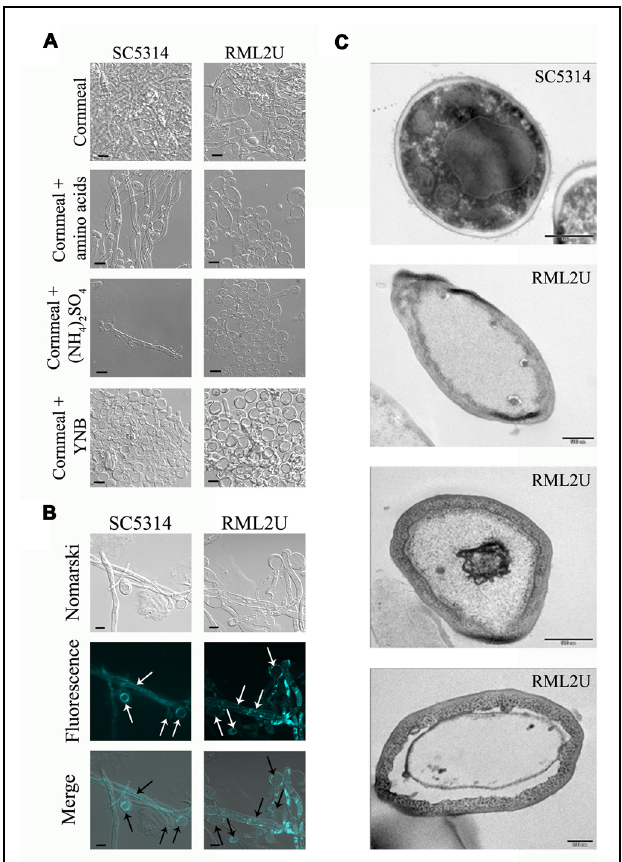
FIGURE 5 | Cornmeal liquid medium mimics the “veil growth” cell phenotype. (A) Amino acids, ammonium (NH 4 ) 2 SO 4 , and yeast nitrogen base (YNB) were added to the cornmeal medium to observe their influence on the RML2U cell phenotype. (B) The cell vacuole was observed by FM4-64 labeling. (C) TEM images of SC5314 and RML2U cells from cornmeal culture. Scale bar: 500 and 200 nm (the last image of